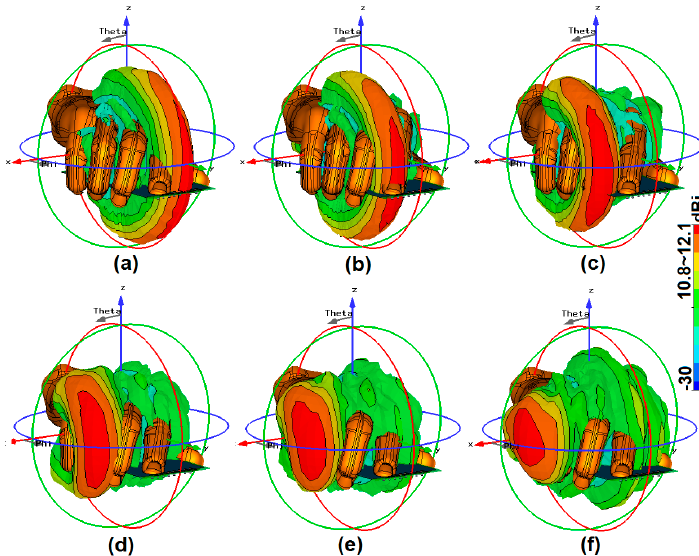
Figure 17. 3D radiation beams of the 5G smartphone antenna in the vicinity of the user’s hands